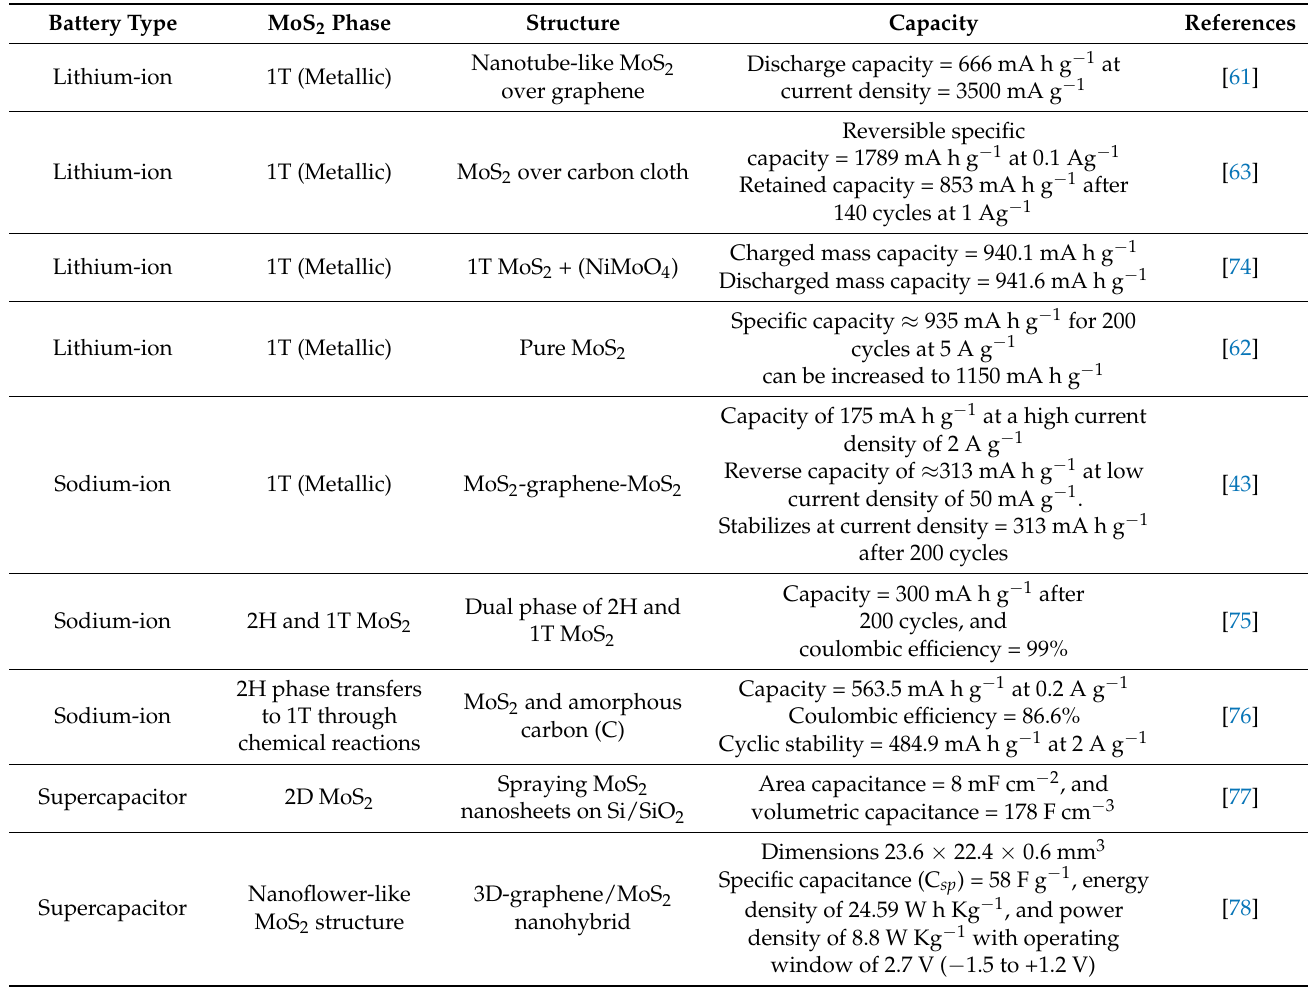
Table 2. Energy storage applications of different MoS 2